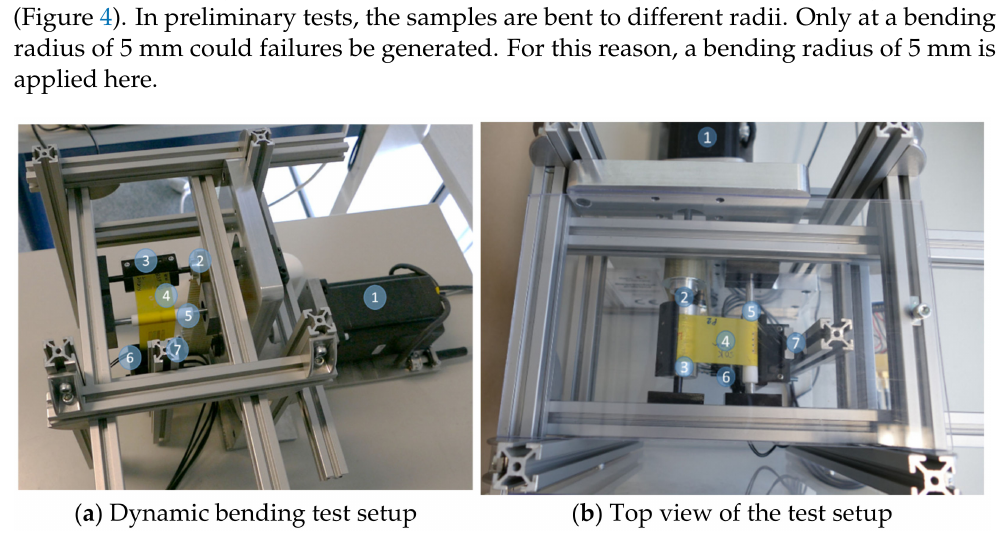
Figure 4. Configuration of the dynamic bending test setup. A motor (1) drives a shaft (2) via a belt. A winding roller (3) is mounted over the shaft. The sample foil (4) to be tested is fixed onto the winding roller. As the motor rotates back and forth, the bending foil is slid over an exchangeable roller (5). This roller determines the bending radius. The foil at the distal end is fixed to the readout electronics (6) to simultaneously monitor the resistances during bending. The electronics slide over a linear guide (7). The weight of the electronics is about 200 g and thus applies a tensile stress of about 2 N to the sample foil during